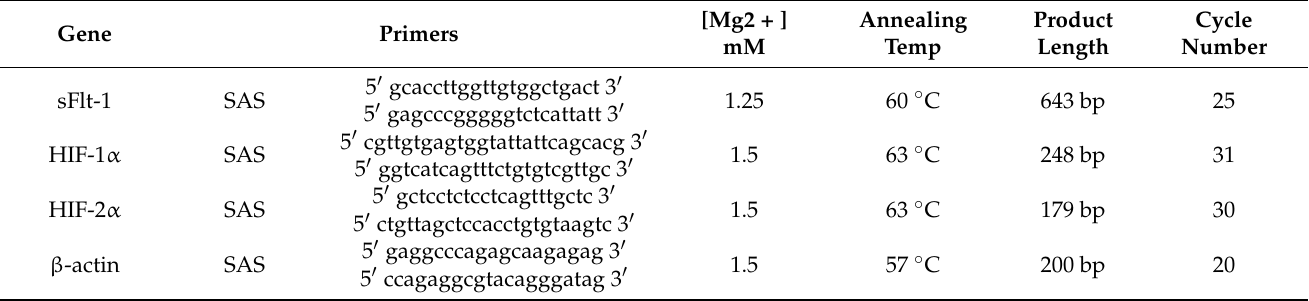
Table 2. PCR primers and conditions used for oxygen sensing/response